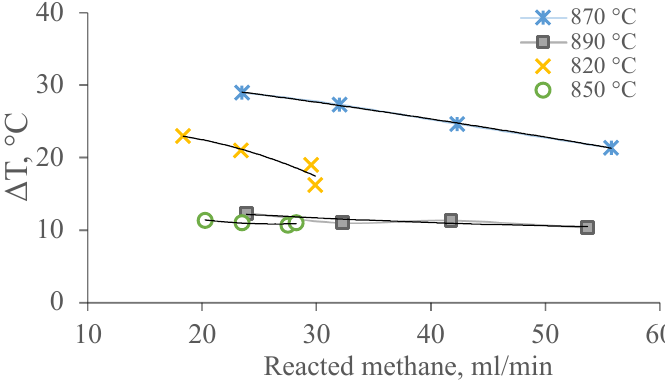
Figure 7. Dependence of the temperature gradient on the amount of methane consumed under the